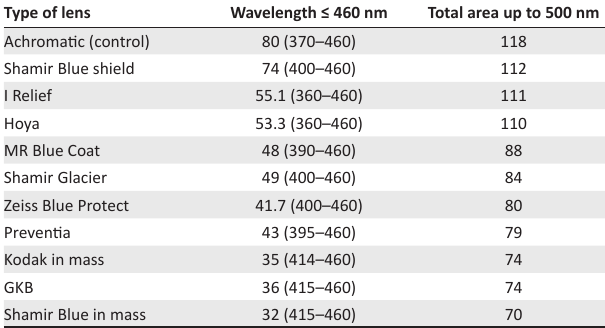
MR Blue Coat (48), Blue Glacier (49), Hoya (53) and then I Relief (55).